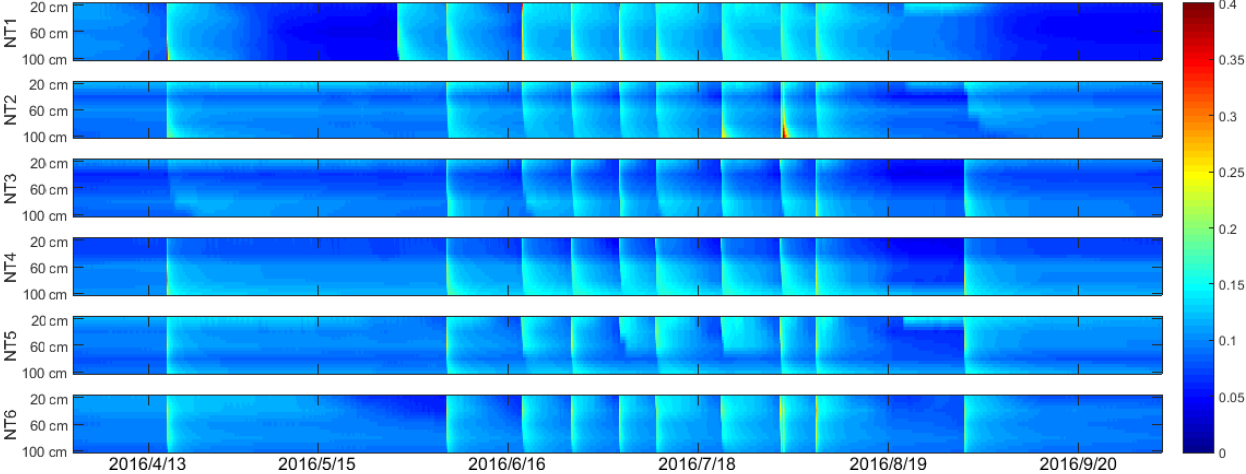
Figure 5. Spatial and temporal variations of soil water content with a time resolution of 10min. The color bar on the right side represents the volumetric soil water content. The time period was from 1 April to 1 October 2016. Irrigation events for NT2–NT6 occurred on 16 April; 2, 15, and 23 June; 1, 7, 18, and 28 July; and 3 and 28 August. NT1 had one more irrigation event on 25 May and one less on 28